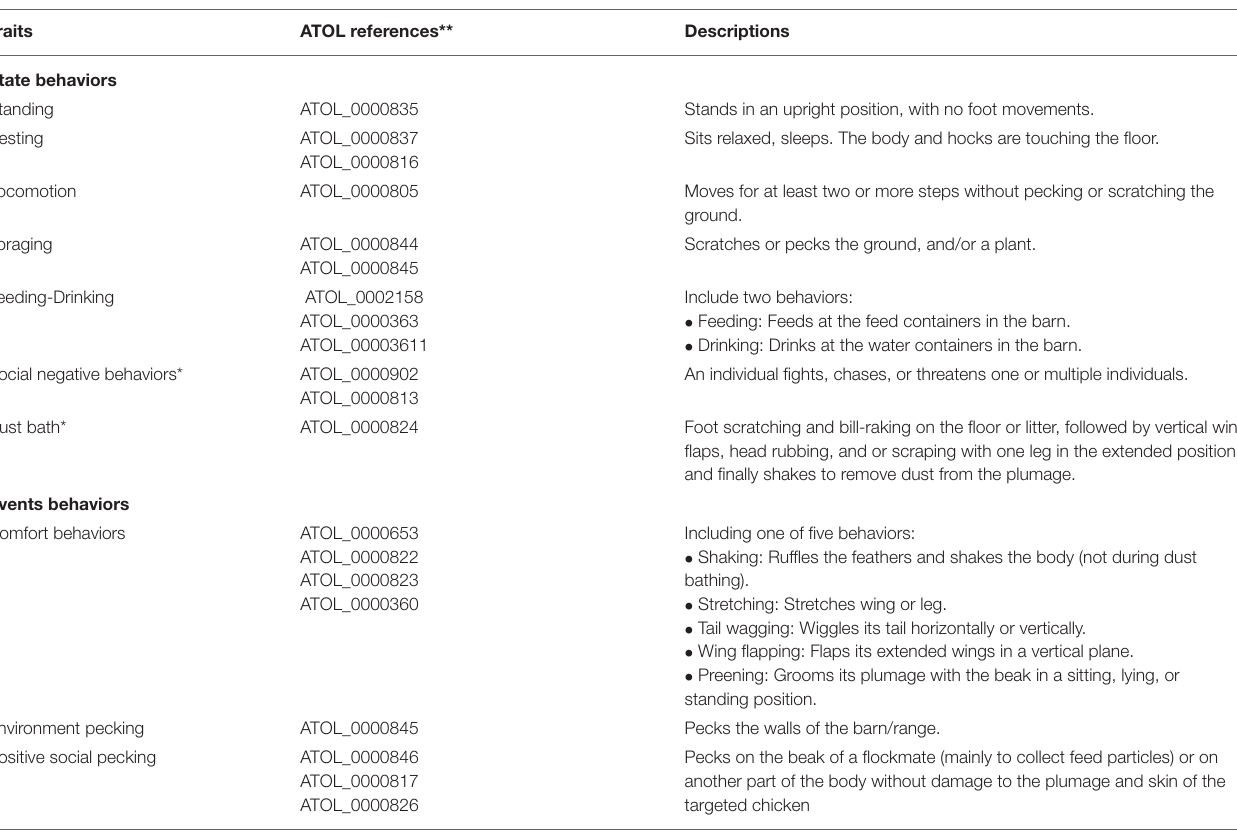
TABLE 1 | Ethogram of recorded behaviors of free-range chickens ( Gallus gallus domesticus ) in their home environment (barn and